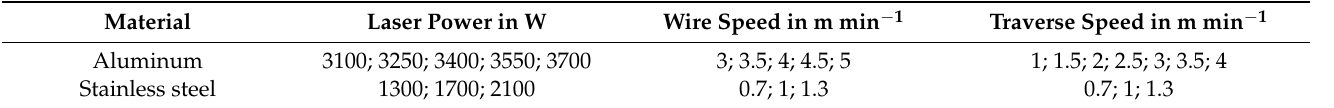
Table 3. Process parameters of the full factorial design for the deposition of single beads with subsequent height and width measurement.